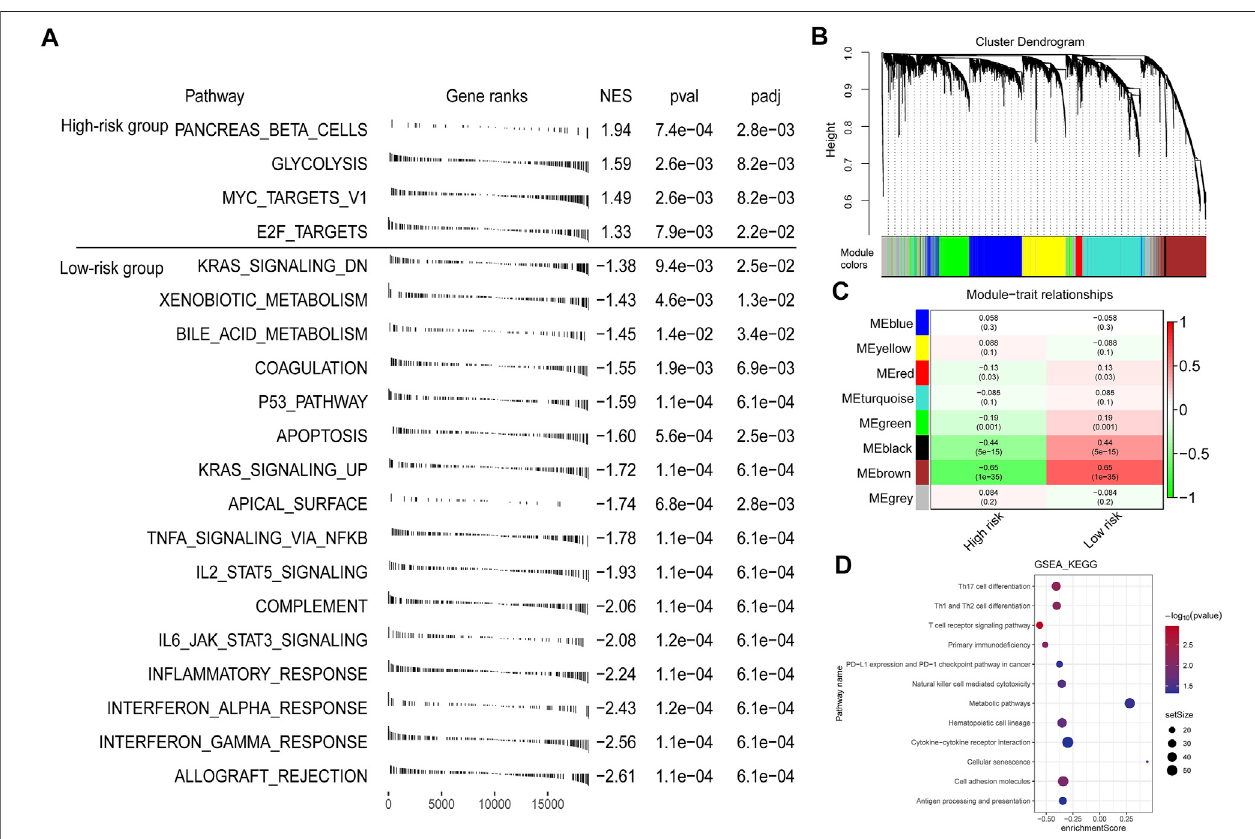
FIGURE 6 | Function analysis of genes correlated with the risk score. (A) GSEA enrichment plots showing enriched gene sets against to hallmark dataset in high- and low-risk groups. NES, normalized enrichment score. (B) A dendrogram of the top 5,000 genes with the most variation clustered based on the topological overlap together. (C) The heatmap showing the association between gene modules and the signature risk score. (D) GSEA annotated by KEGG gene sets for the brown module